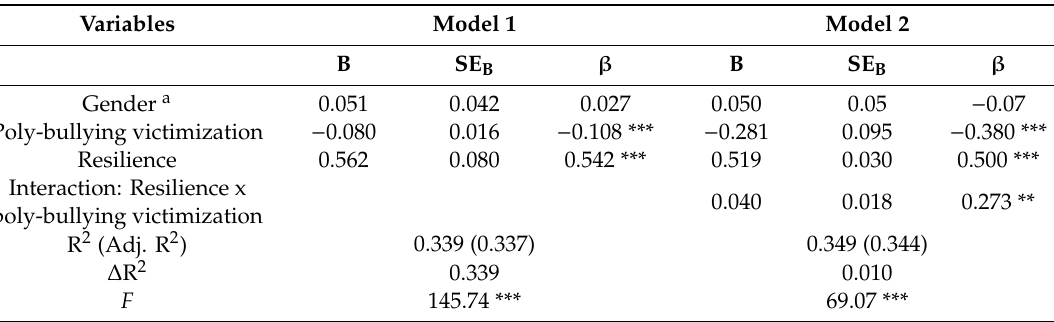
Table 3. Linear regression analyses examining the associations of resilience and bullying victimization and relatedness to subjective well-being as the